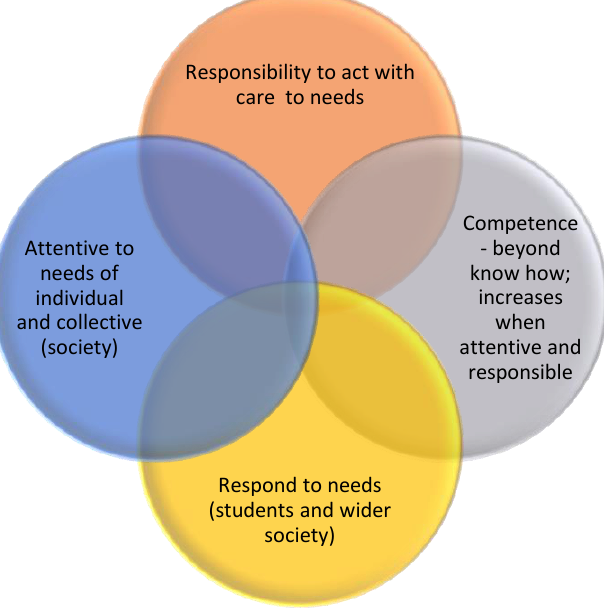
Figure 2 Elements of Care (Tronto, 1993,